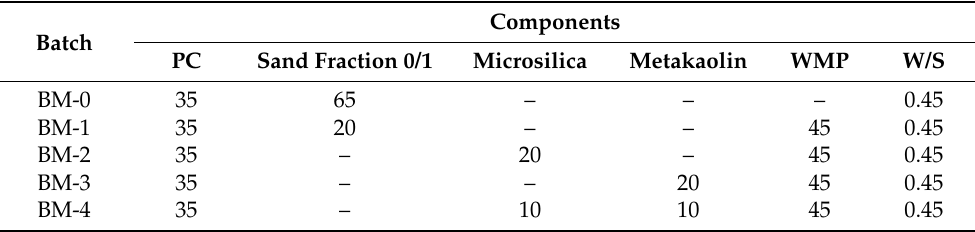
Table 3. Compositions of mixes with microsilica and metakaolin additives and WMP particles for calorimetric investigations (components mass by weight,